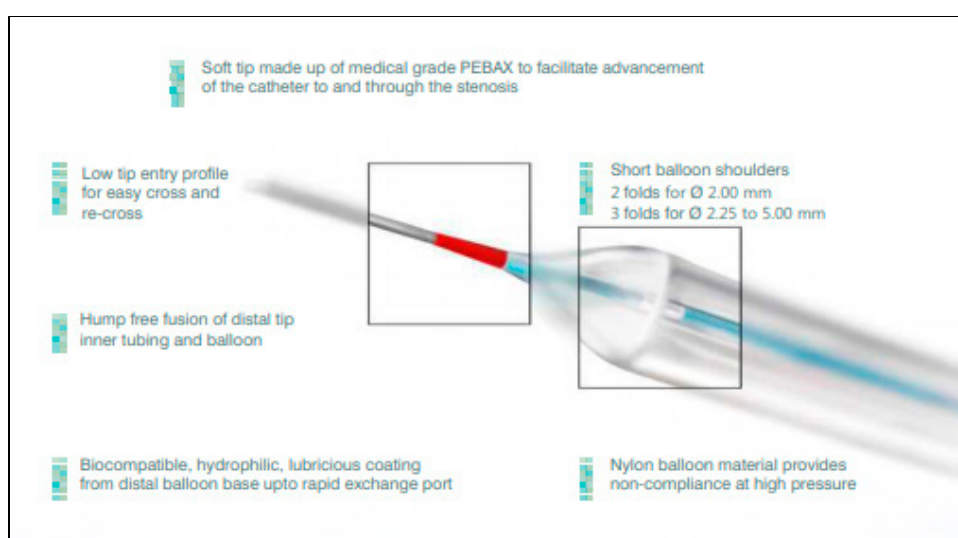
Figure 1. Mozec™ NC Rx PTCA balloon dilatation catheter.